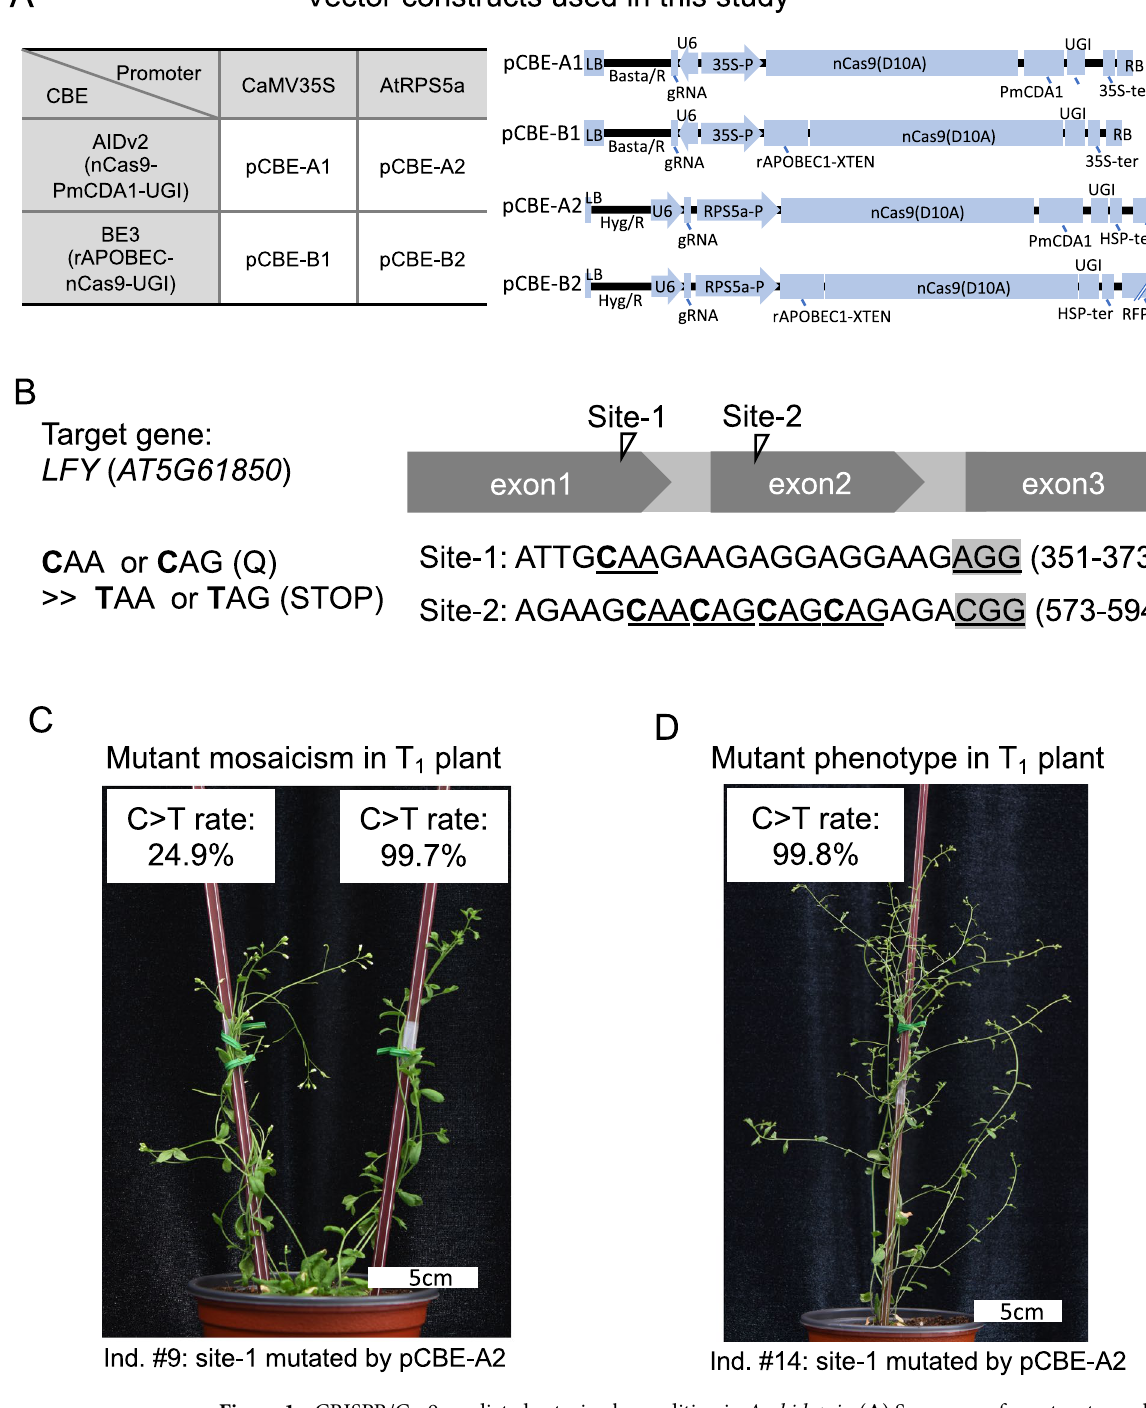
Figure 1. CRISPR/Cas9-mediated cytosine base editing in Arabidopsis . ( A ) Summary of constructs used in this study and detailed construct composition for each. LB left border, Basta/R Basta resistance, U6 U6 promoter, UGI Uracil glycosylase inhibitor, RB right border, HSP-ter heat shock protein terminator, Hyg/R Hygromycin resistance, RFP red fluorescent protein. ( B ) All specific cytosine (C) positions targeted in each site are presented in bold and codons are underlined. The nucleotide positions of single guide RNA (gRNA) sites are shown in parentheses. The protospacer adjacent motif (PAM) is underlined. ( C,D ). Examples of T 1 plants showing lfy mutant phenotypes. ( C ) An example T 1 plant individual transformed with pCBE-A2 targeting site-1, showing the wild-type phenotype (left) and the lfy mutant phenotype (right). C-to-T conversion rates were analyzed using tissues collected from the left or right part for targeted deep sequencing. ( D ) A T 1 individual plant transformed with pCBE-A2 targeting site-1 showing the lfy mutant phenotype only. Ind.: